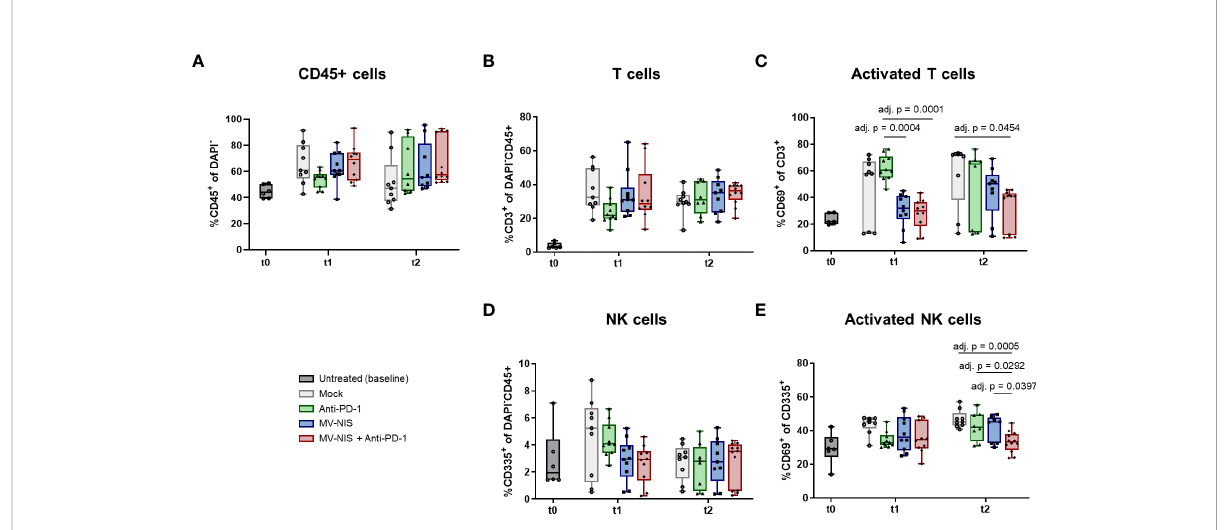
FIGURE 4 Tumor-in fi ltrating lymphocytes after MV-NIS and anti-PD-1 treatment. After treatment as depicted in Figure 3A, tumors were explanted at t0, t1, and t2. Tumor samples were prepared for fl ow cytometry. The percentages of (A) CD45+ cells among live cells (DAPI-), (B) T cells (CD3+) among live CD45+ cells, (C) activated T cells (CD3+ CD69+) among live T cells, (D) NK cells (CD335+) among live CD45+ cells, (E) activated NK cells (CD335+ CD69+) among live NK cells were determined. Box and whisker plots with whiskers depicting minimal and maximal detected abundances as well as median in each group are shown. Data were analyzed by one-way ANOVA for each timepoint with Tukey ’ s post-test. Multiplicity-adjusted p values < 0.05 are shown. adj. p = adjusted p value.